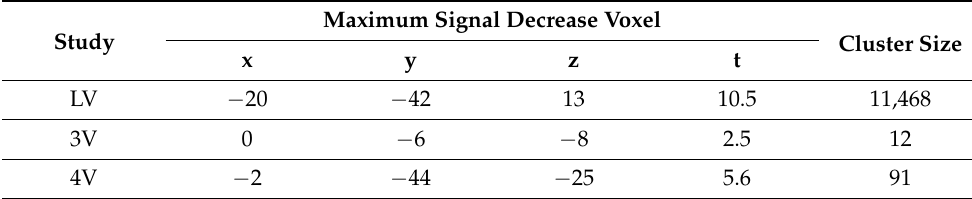
Figure 4. REM-locked periventricular BOLD signal decrease (group analysis, n = 24). Significance was thresholded at p < 0.05, uncorrected (T = 1.7) and additionally at a spatial extent of >5 contiguous voxels. ( A ) orthogonally oriented ‘glass brain’ views. ( B ) the lower panel was thresholded higher at p < 0.05 corrected for multiple comparison (T = 6.0) to show that the robust signal decrease centers around walls of the lateral ventricle. Results of analyses with SPM2 were previously published [13]. Table 4. REM-locked periventricular BOLD signal decrease (group analysis, n =